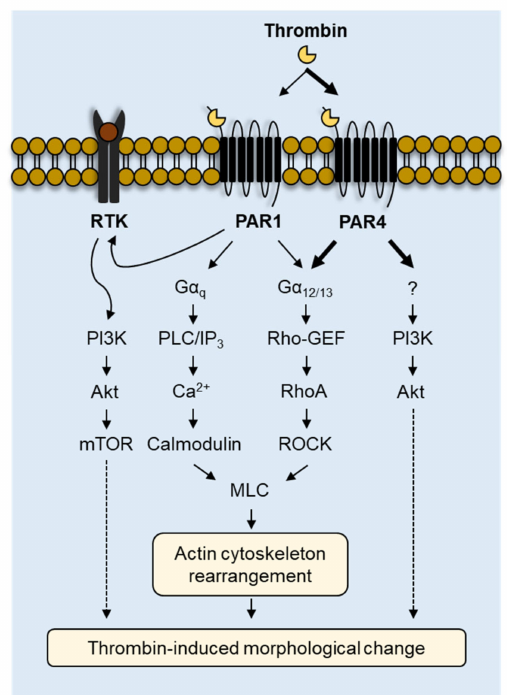
Figure 8. Schematic model of the underlying mechanisms involved in thrombin-induced morpholog- ical changes via PAR1 and PAR4 in MEG-01